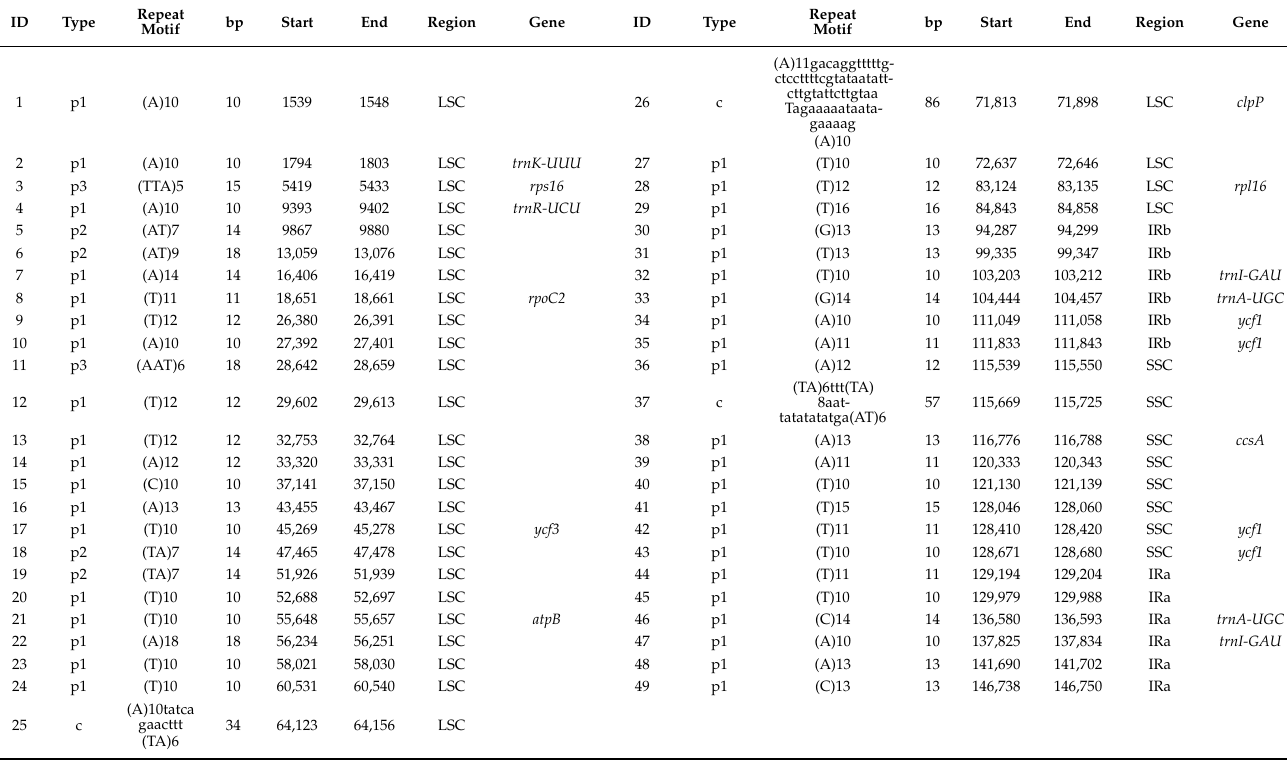
Table 3. Repeat sequences in the chloroplast genome of the wild S. divaricata.